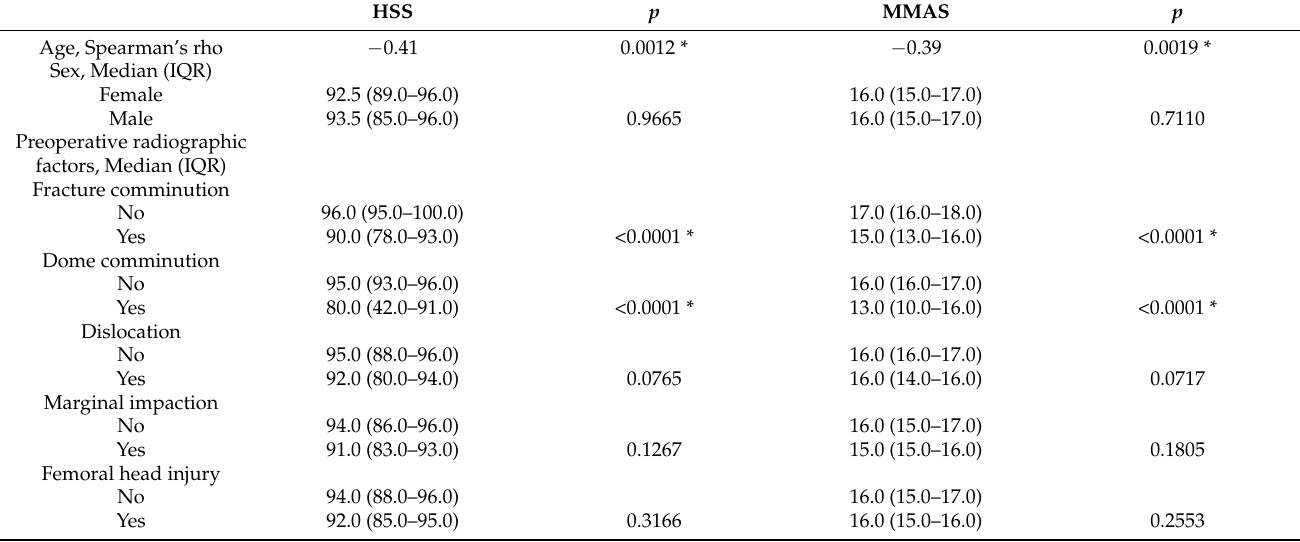
Table 2. The prognostic factors related to clinical outcomes (HHS and MMAS).